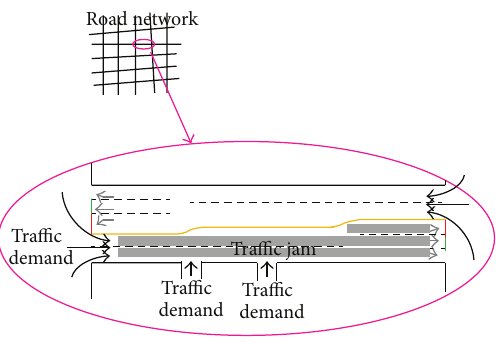
Figure 1: Simple representation of road geometry.